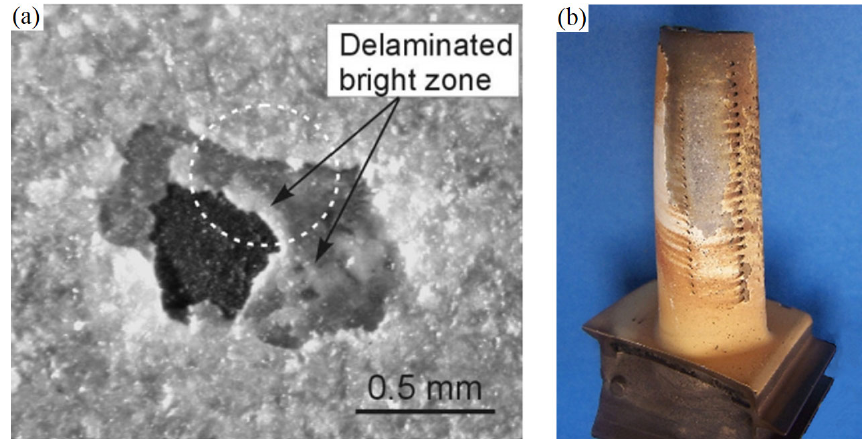
Fig. 57 Damage and spalling of TBCs under erosion conditions: (a) optical image showing the impact damage and (b) Macro photos after erosion failure. Reproduced with permission from Ref. [332] for (a), © Elsevier Science B.V. 2002; Ref. [334] for (b), © Elsevier Ltd.